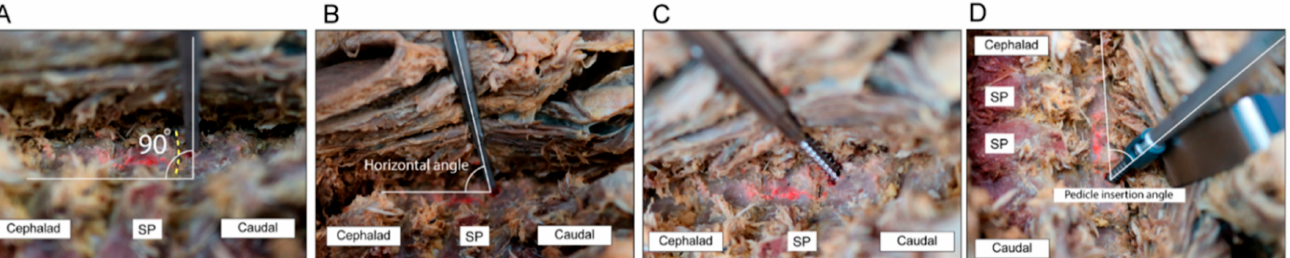
Figure 3. Cadaver images showing the surgical technique. For the technical expression of pedicle screw placement using MPPP, when it is implemented on actual patients, there are concerns about the limitation of visualization of anatomical landmarks due to surgical site contamination or bleeding. Therefore, technical expression was implemented for cadaver for pedicle screw placement using MPPP. ( A ) The pedicle probe was vertically inserted up to a depth corresponding with the lateral mass distance of the specific pedicle. ( B ) The pedicle probe was then inserted to a depth 2 mm less than the pedicle total length, directed at an angle corresponding with the appropriate horizontal and pedicle insertion angles (PIAs). ( C ) A tap was used to expedite screw insertion and lessen the torque required to insert the screw. A ball-tipped probe was used to confirm the integrity of the pedicle borders after tapping. ( D ) A 3.5 mm pedicle screw of appropriate length was inserted following the same horizontal angle and PIA. SP, spinous